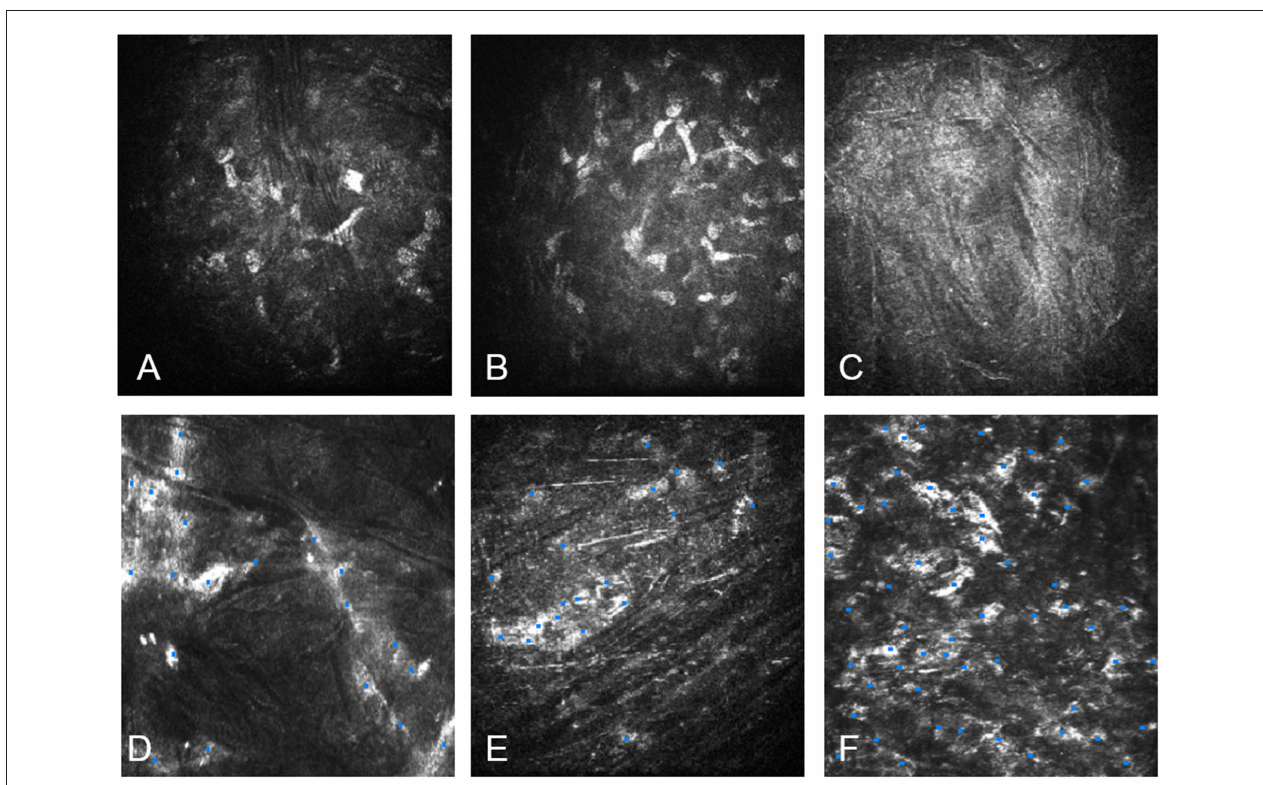
FIGURE 6 | Confocal microscopy study with HRT3 RCM (Heidelberg). (A) Confocal microscopy of the anterior corneal stroma with case 1, G-1. Notice the few nuclear corneal cell density. (B) Nuclear cell density in the anterior stroma with case 1 at 12 months post-operative. Notice the increment of the cell density. (C) Acellular implanted lamina with case 5, G-2 at 1 month post-operative. (D) Recellularization of the anterior surface of the implanted decellularized lamina in the same case 5 at 12 months postoperative. (E) The posterior surface of the recellularized lamina with case 13, G-3 at 1 month after the operation: the presence of few ADASCs with similar morphology of keratocytes. (F) The posterior surface of the recellularized lamina with case 13 at 12 months after surgery: Observe the abundant number of stromal